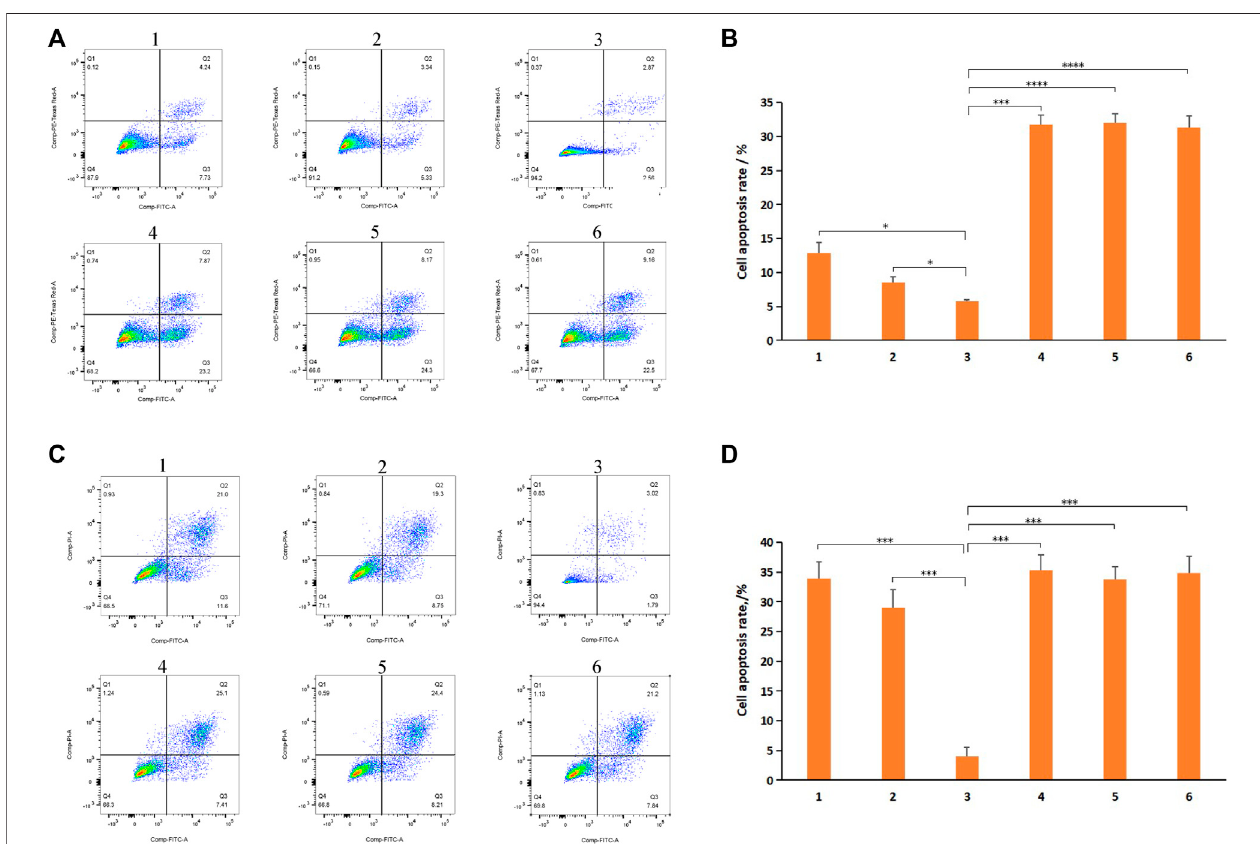
FIGURE8| EffectsofmicellesandfreeDOXonapoptosisofH9c2cellsandBEL-7402cells:DSPE-PEG-C60:DOX=10:1(W/W)(1),DSPE-PEG-C60:DOX=15:1 (W/W) (2), control (3), DSPE-PEG-NH 2 : DOX = 10:1 (W/W) (4), DSPE-PEG-NH 2 : DOX = 15:1 (W/W) (5), and free DOX (6). Cells were treated with micelles or free DOX at equivalent concentrations of 500 nM DOX (H9c2 cells) or 1,000 nM DOX (BEL-7402 cells) for 24 h, followed by annexin V/PI staining and fl ow cytometry detection. (A) Representativepseudo-colorplotsofannexinV/PIstainingofH9c2cells. (B) ApoptosisratioofthecalculatedH9c2cells. (C) Representativepseudo-colorplotsof Annexin V/PI staining of BEL-7402 cells. (D) Apoptosis ratio of the calculated BEL-7402 cells. The values presented are the means ± standard deviations of